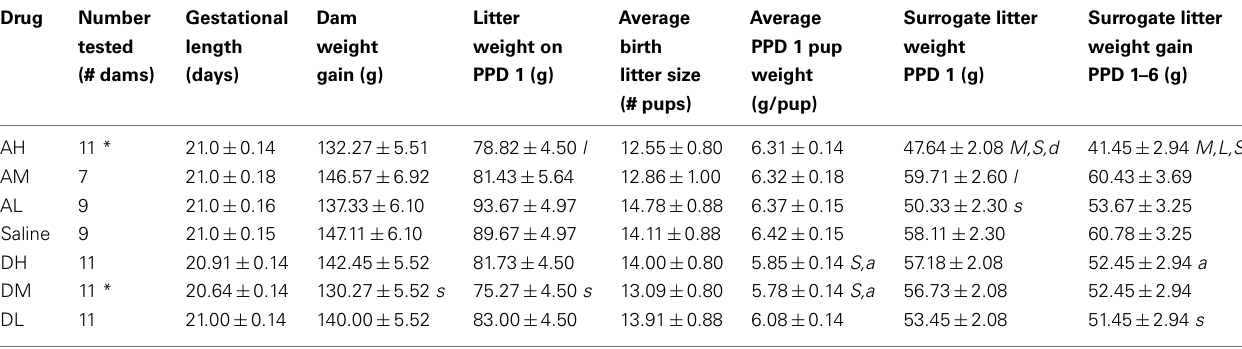
Table 2 | Gestational